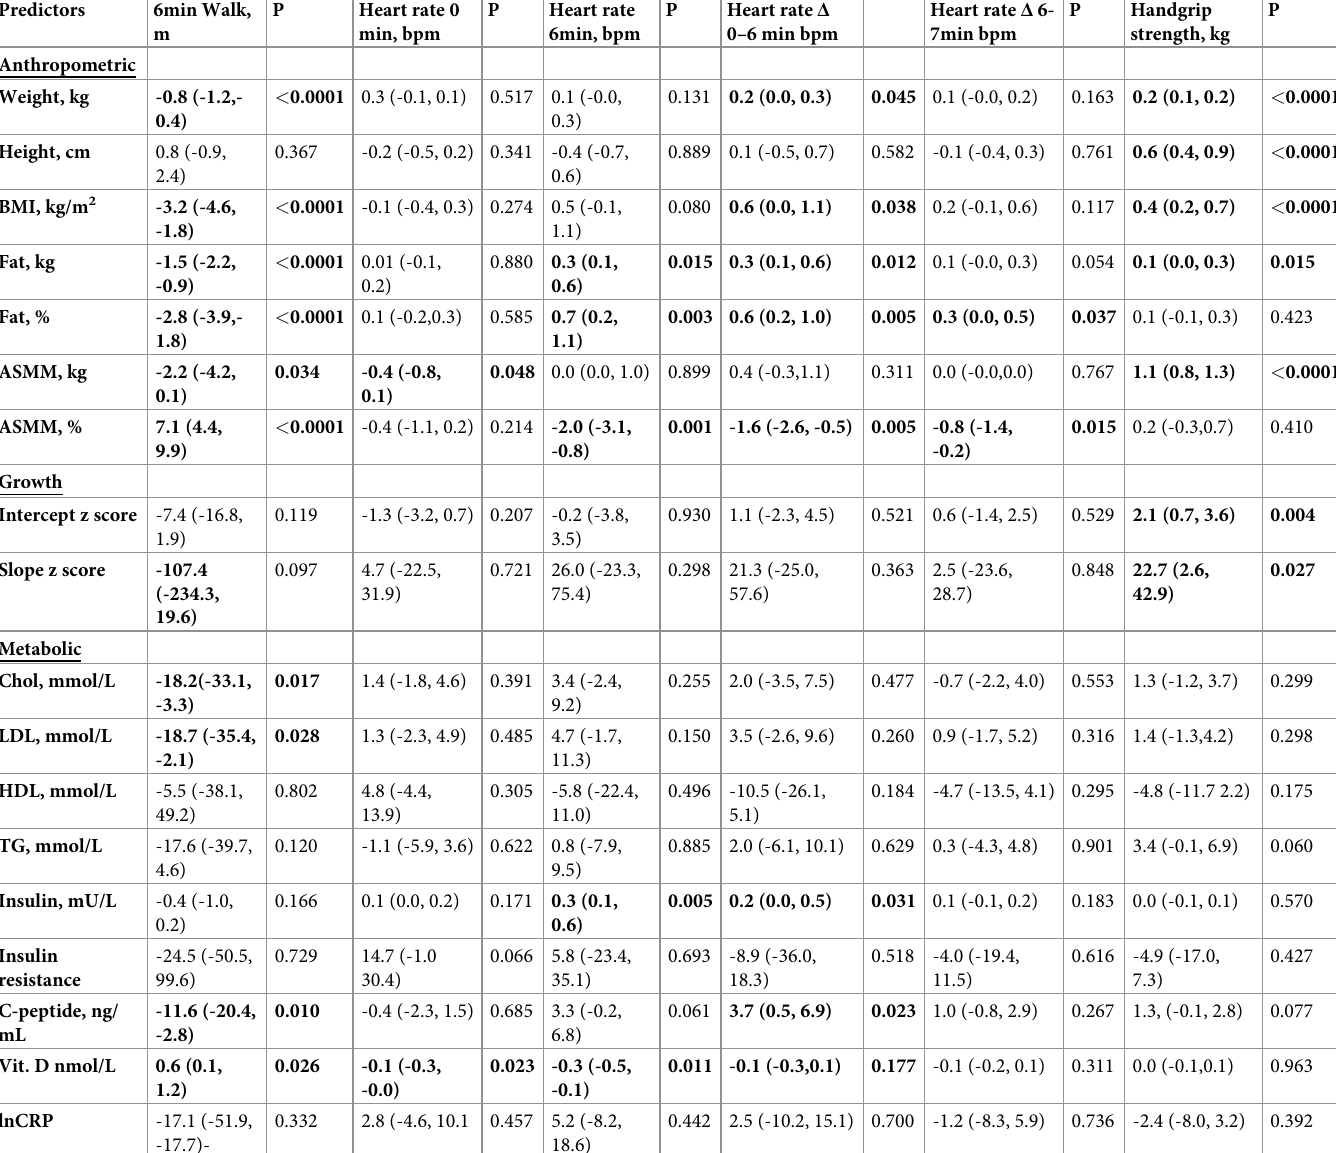
Table 3. Predictors of physical function measures for 102 boys by linear regression adjusted for age.